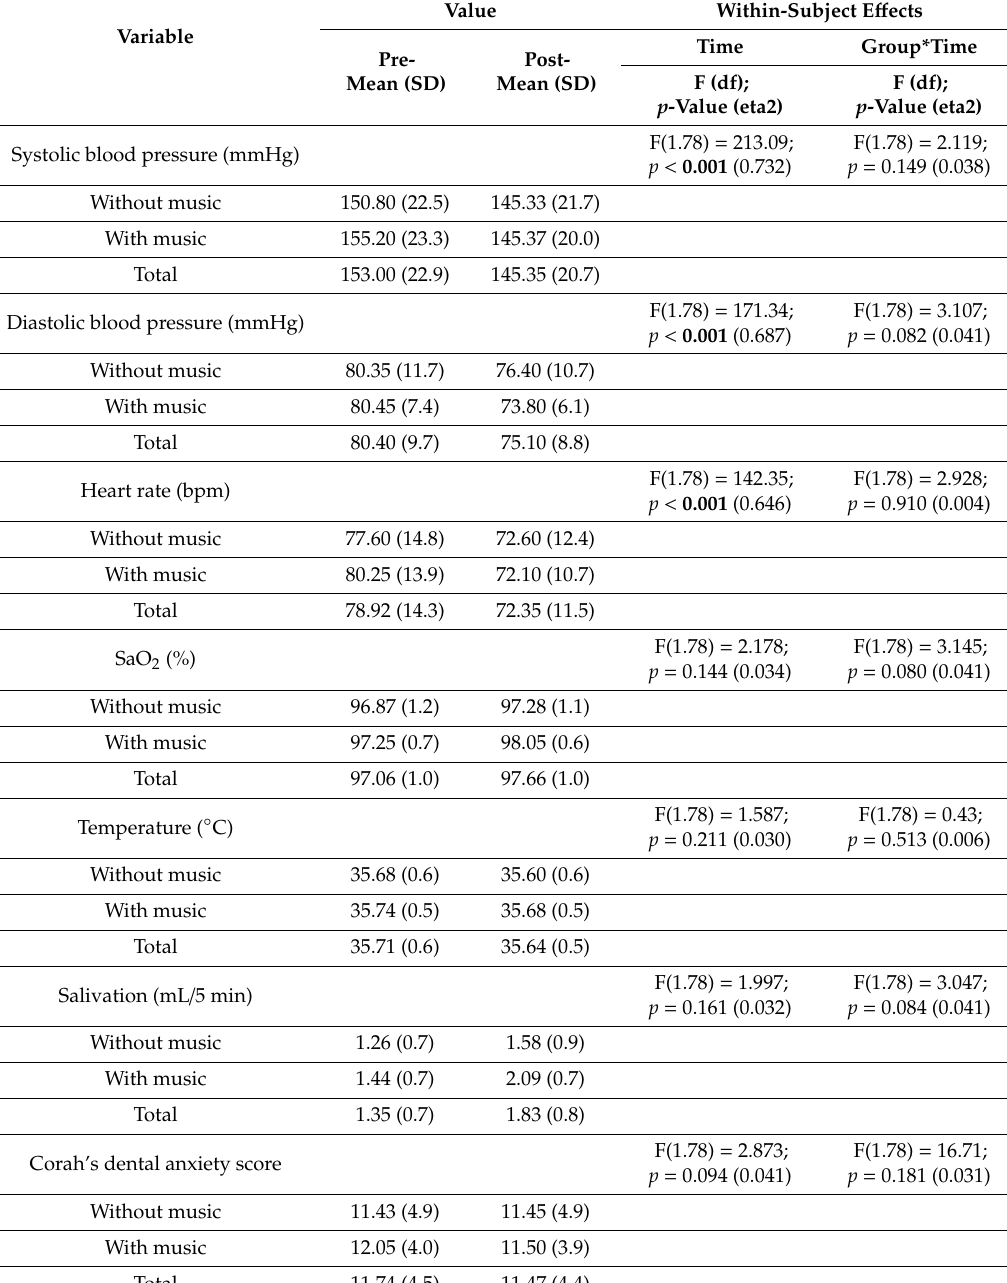
Table 3. Comparison of pre- and post-consultation changes in the study measures between intervention and control